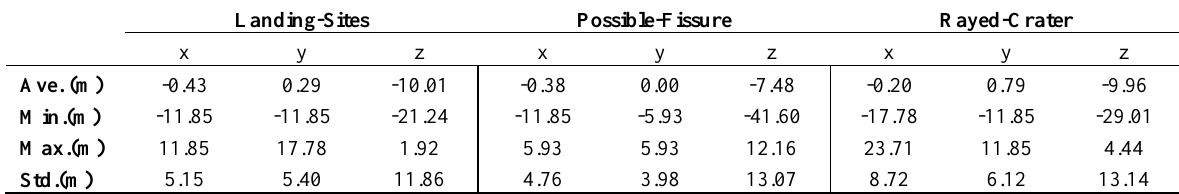
Table 3. Discrepancies between the CTX DEMs and the HiRISE DEMs after co-registration.